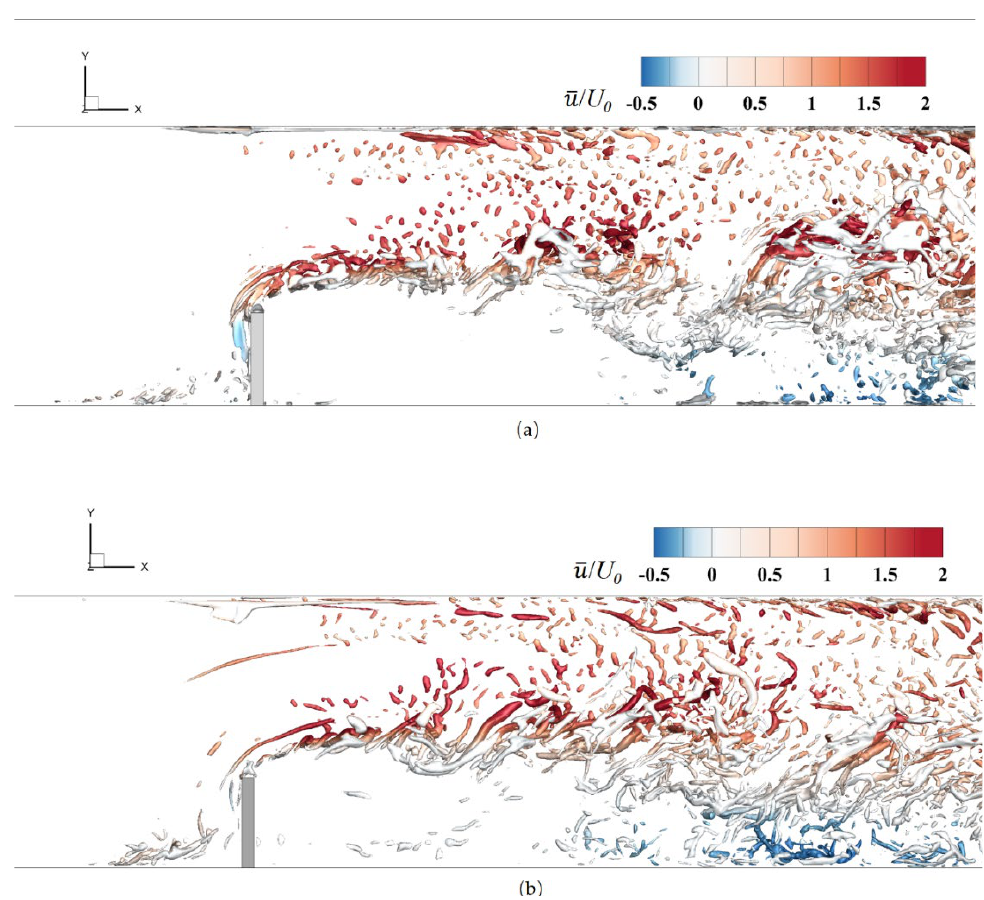
Figure 15. Visualization of the coherent structures deduced from the iso-surfaces of the Q − criterion as computed for ( a ) Case 1 and ( b ) Case 2.